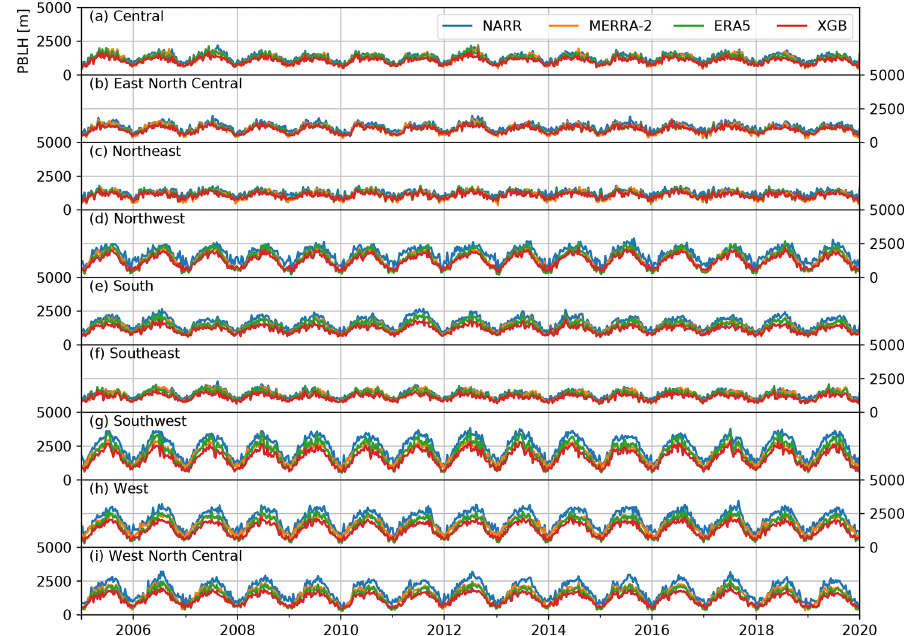
Figure A1. Weekly average PBLH at 13:00–14:00LST over nine climate regions across the CONUS. Atmos. Meas. Tech., 16, 563–580,